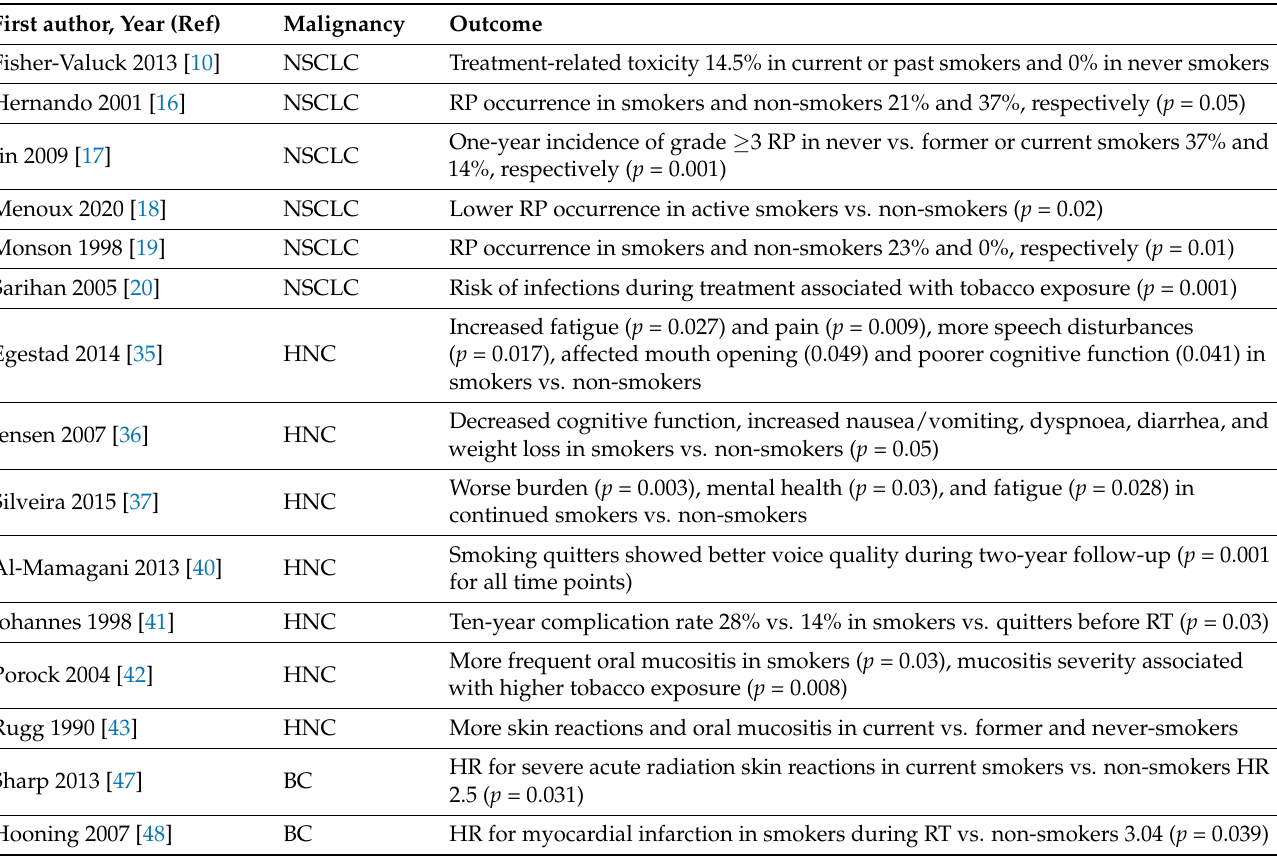
Table 5. Impact of tobacco smoking on treatment toxicity and